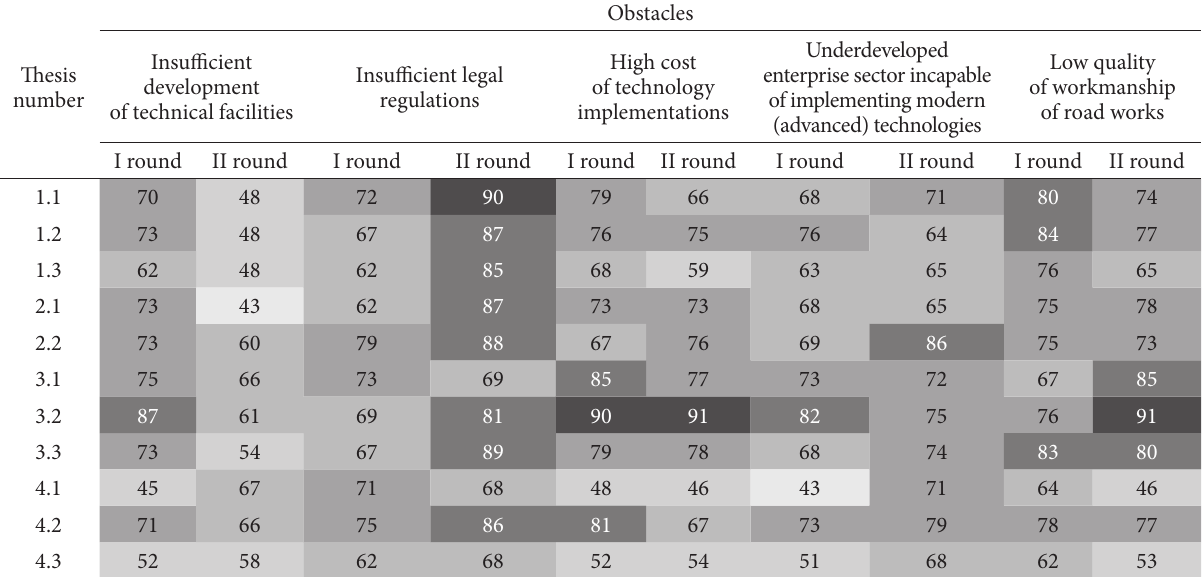
Table 3. Power of factors hindering the implementation of the Delphi theses